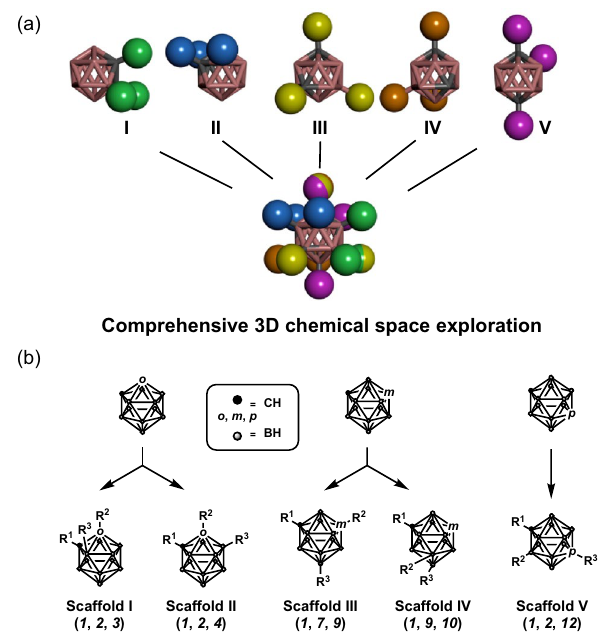
Figure 1. ( a ) The five types of trisubstituted carboranes that can cover all directions in a chemical space. ( b ) Synthetic strategy for the production of the described trisubstituted